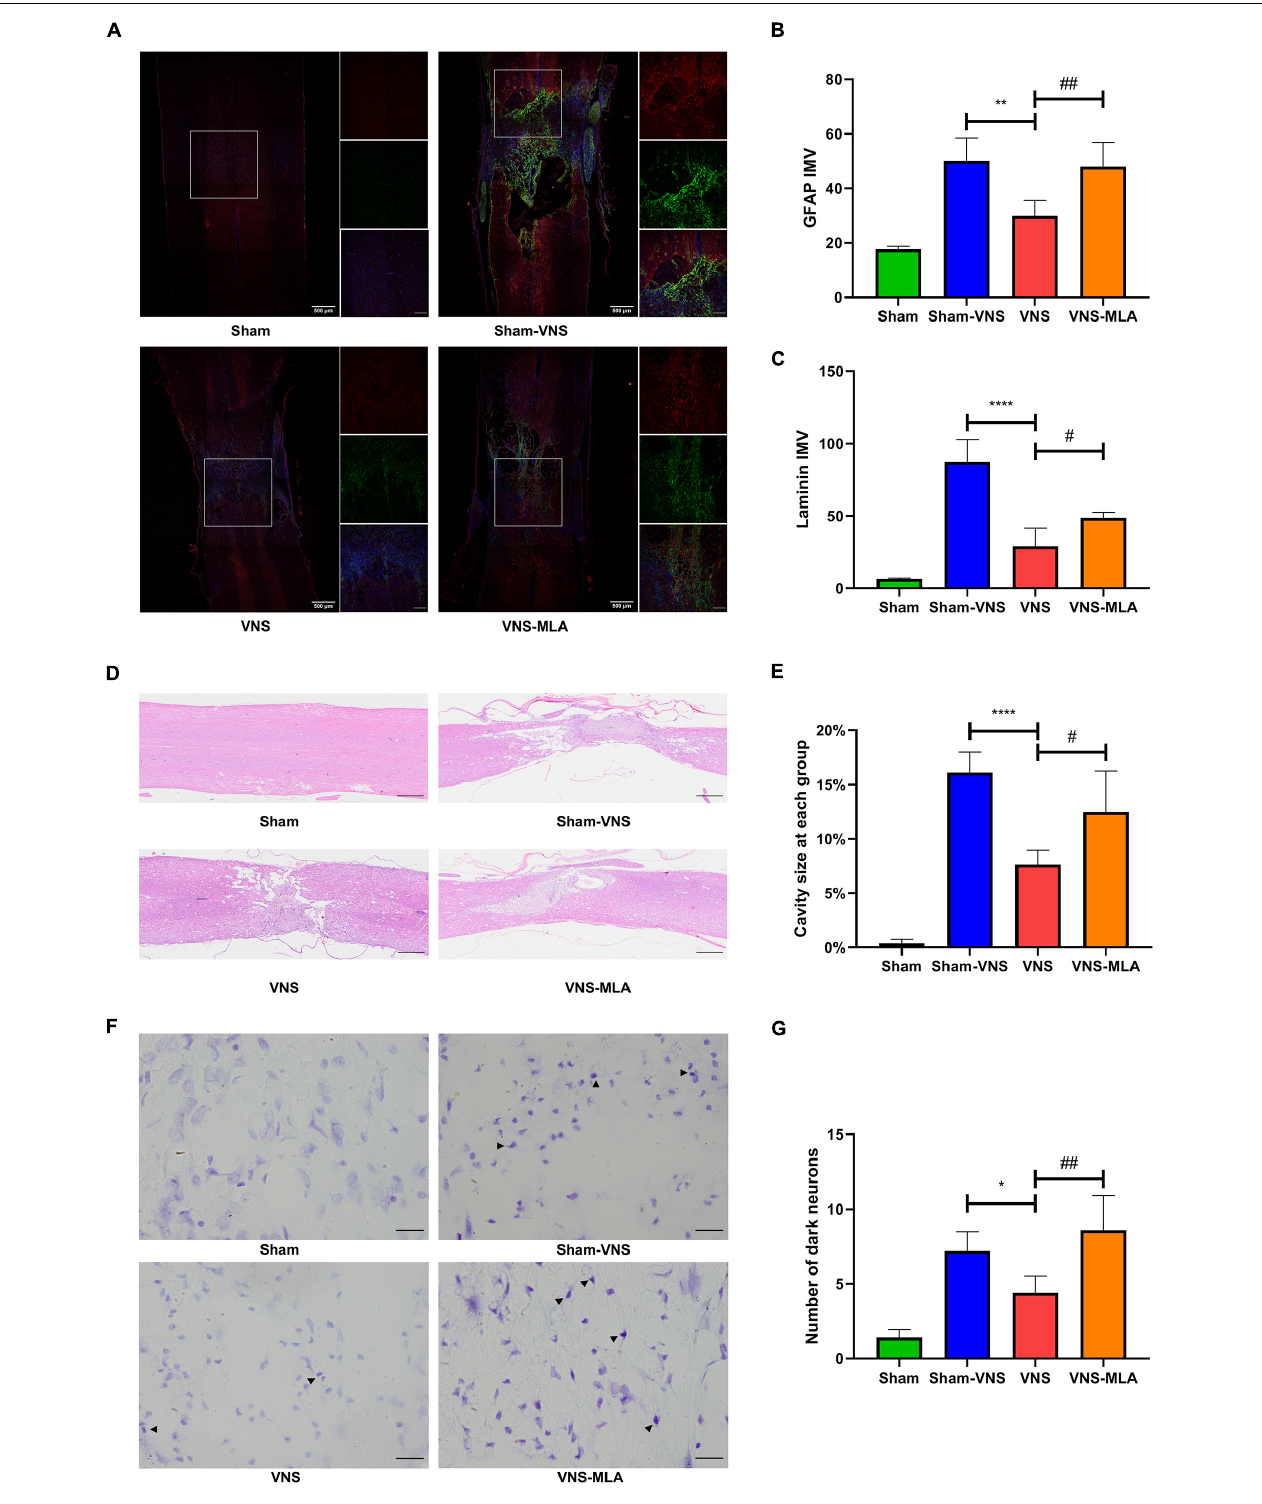
FIGURE 2 | Vagus nerve stimulation (VNS) decreases spinal cord tissue damage. (A–C) Representative Immunofluorescence (IF) staining images of each group post injure 28 days, and bar charts show the fluorescence intensity mean value (IMV) for GFAP and Laminin, n = 5 per group, scale bar = 500 or 200 µ m. (D,E) Representative Hematoxylin-eosin (HE) staining images 28 days after injury and quantification data of cavity necrotic tissue in each group, n = 5 per group, scale bar = 500 µ m. (F,G) Representative Nissl staining images 28 days after injury and quantification of the numbers of Nissl-stained dark neurons in each group, n = 5 per group, scale bar = 20 µ m. * P < 0.05, ** P < 0.01, and **** P < 0.0001 between the Sham and Sham-VNS groups, # P < 0.05, ## P < 0.01 between the VNS and VNS-MLA groups.